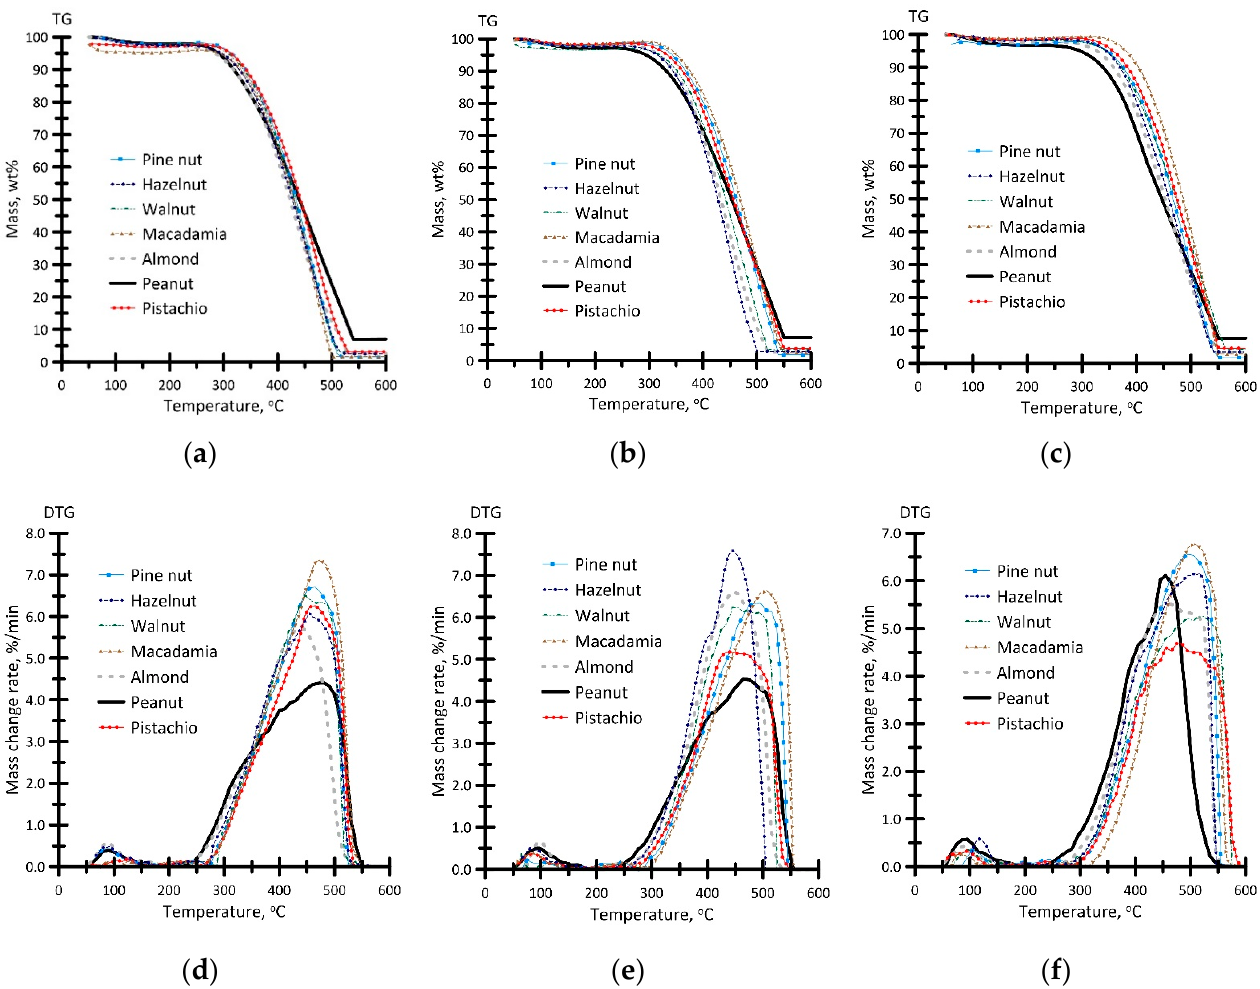
Figure 9. TG ( a – c ) and DTG ( d – f) profiles for the oxidation process of the biochar samples produced at different tempera-